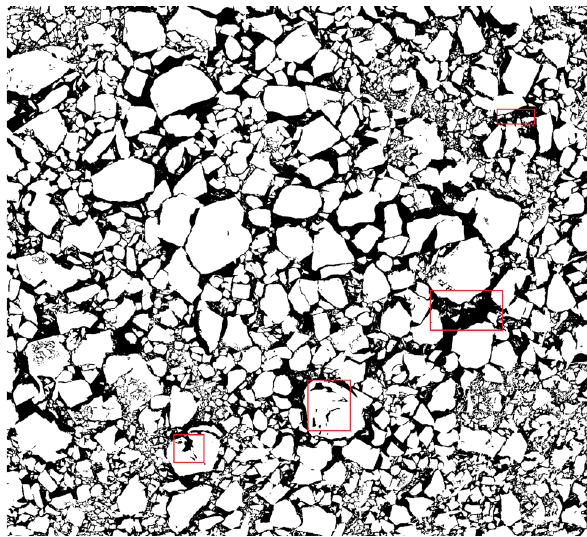
Figure 6. Otsu method image binarization.